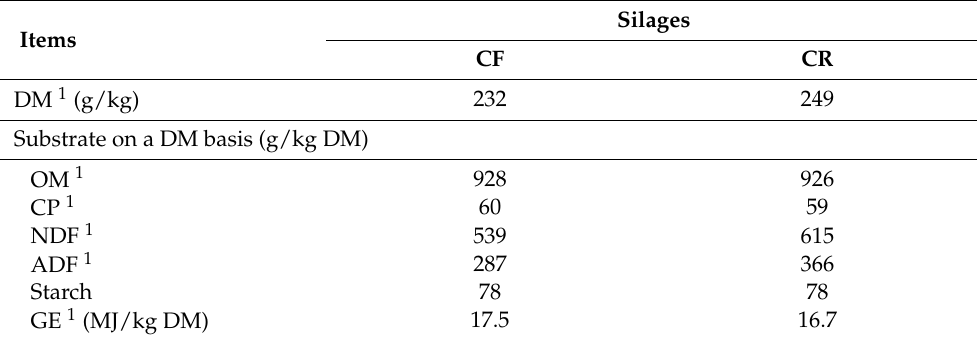
Table 1. Chemical composition of corn stover after fresh-corn harvested (CF) or corn stover after ripe-corn harvested (CR)